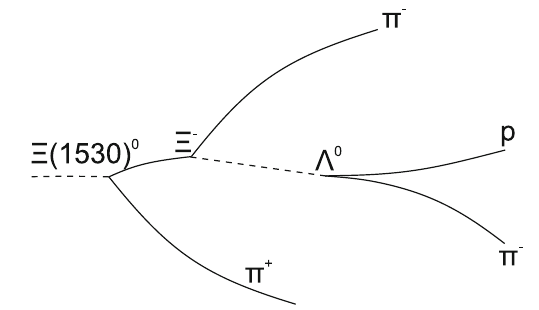
Fig. 2 Schematic sketch of the (cid:2)( 1530 ) 0 decay scheme